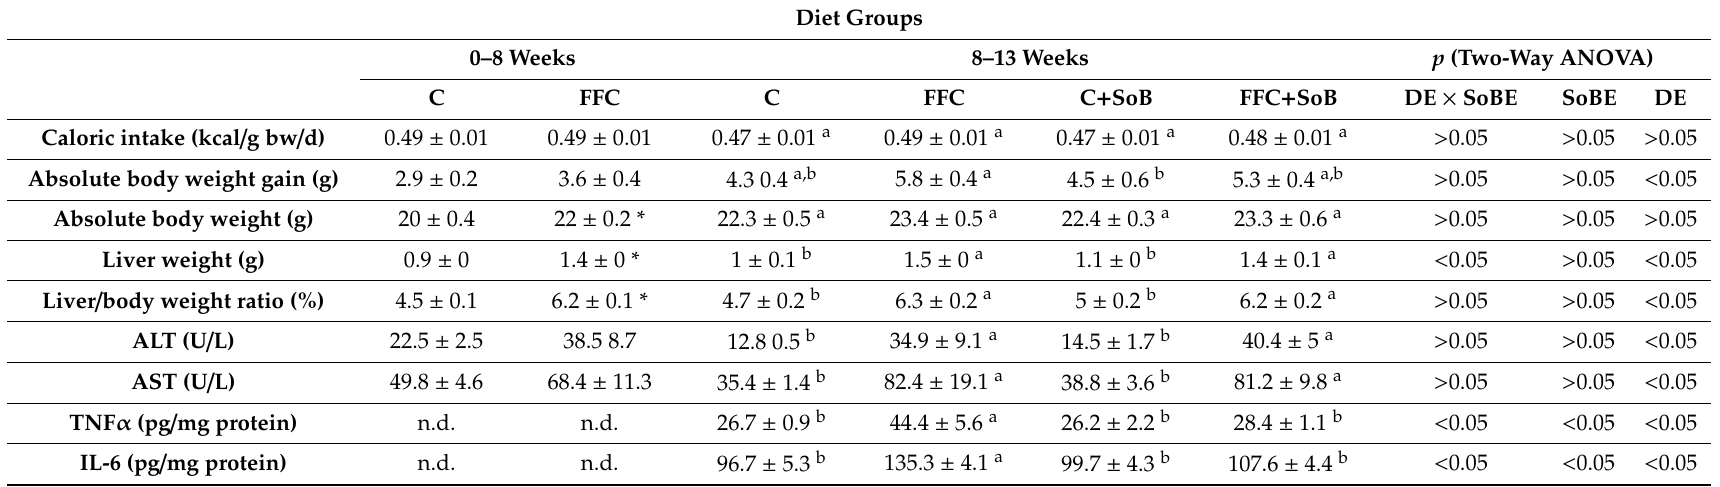
Table 1. E ff ect of an oral supplementation of SoB on caloric intake, body- and liver weight as well as parameters of liver damage in mice with FFC-induced